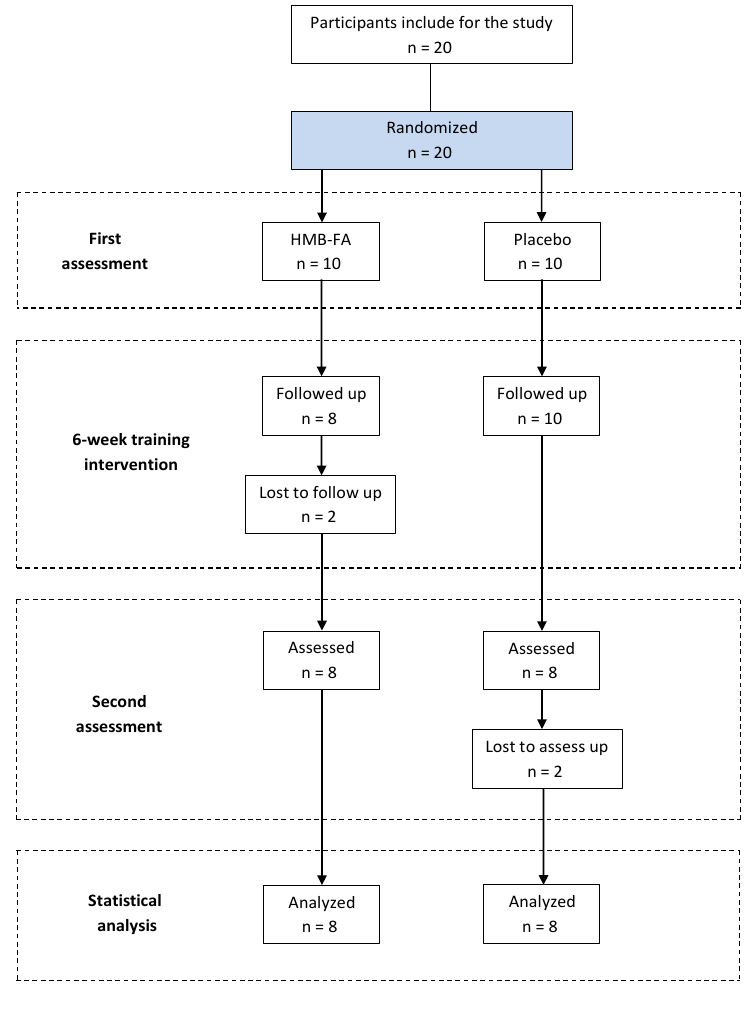
Figure 1. Study flow.